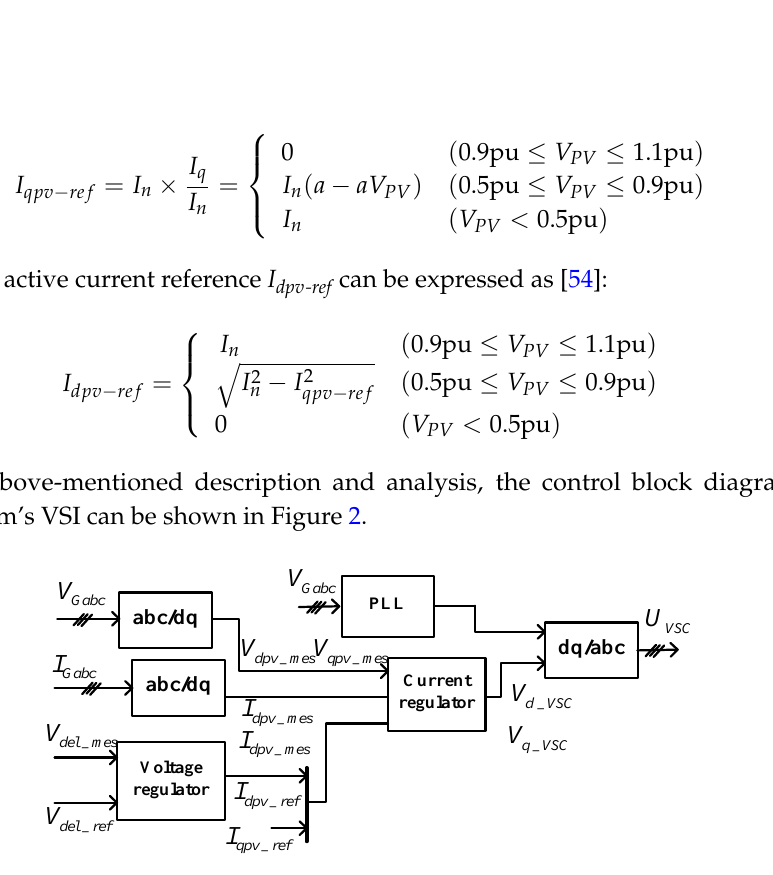
Figure 2. Control block diagram of the voltage source inverter of the PV generation system. PLL: phase locked loop; and VSC: voltage source converter.